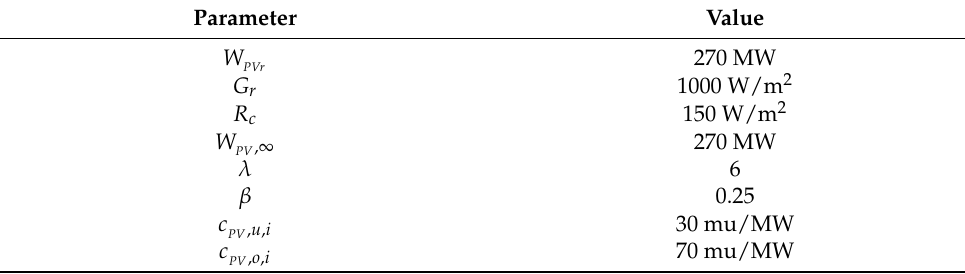
Table 3. Parameters taken for the cost function of the solar generator [4].